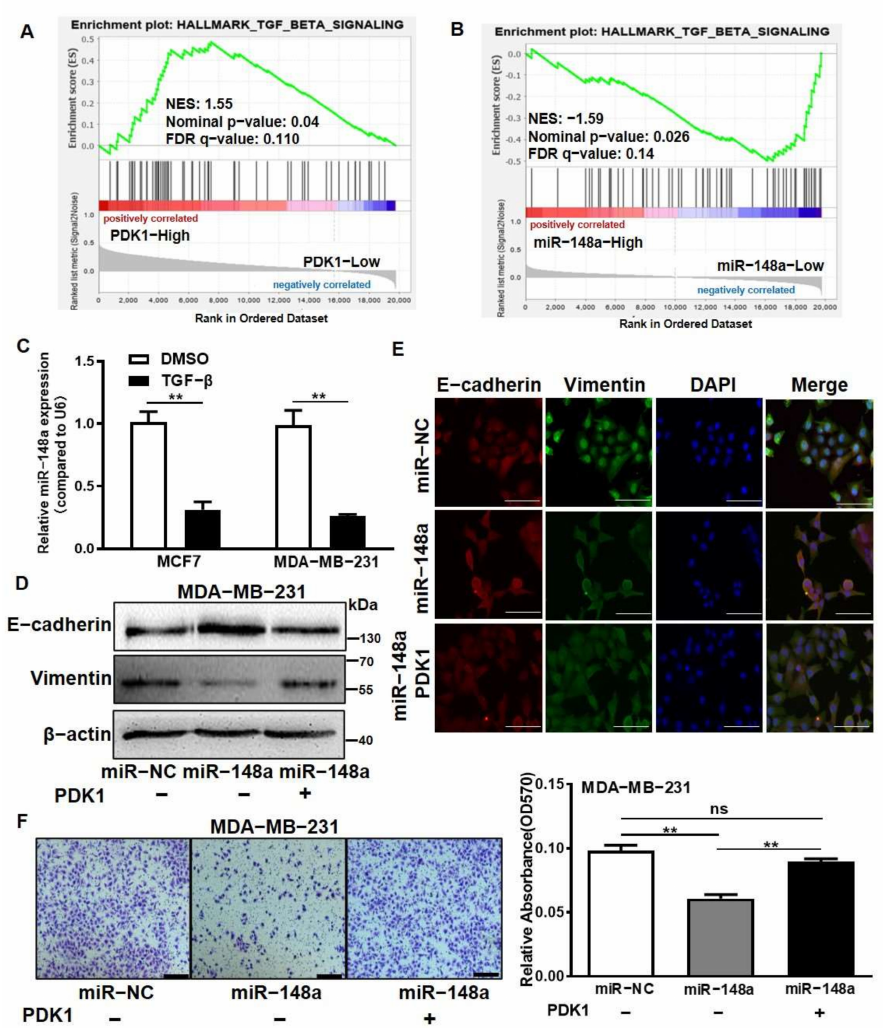
Figure 7. PDK1 suppression by miR-148a inhibited epithelial–mesenchymal transition and cell migration. ( A , B ) The GSEA program was employed to analyze KALLMARK_TGF_BETA_SIGNALING pathway enrichment scores between PDK1 ( A ) and miR-148a ( B ) high- and low-expression groups using TCGA BRCA dataset. ( C ) TGF- β was used to treat MCF7 and MDA-MB-231 cells, and the expression levels of miR-148a were detected by qRT-PCR. ( D ) The protein levels of E-cadherin and Vimentin were